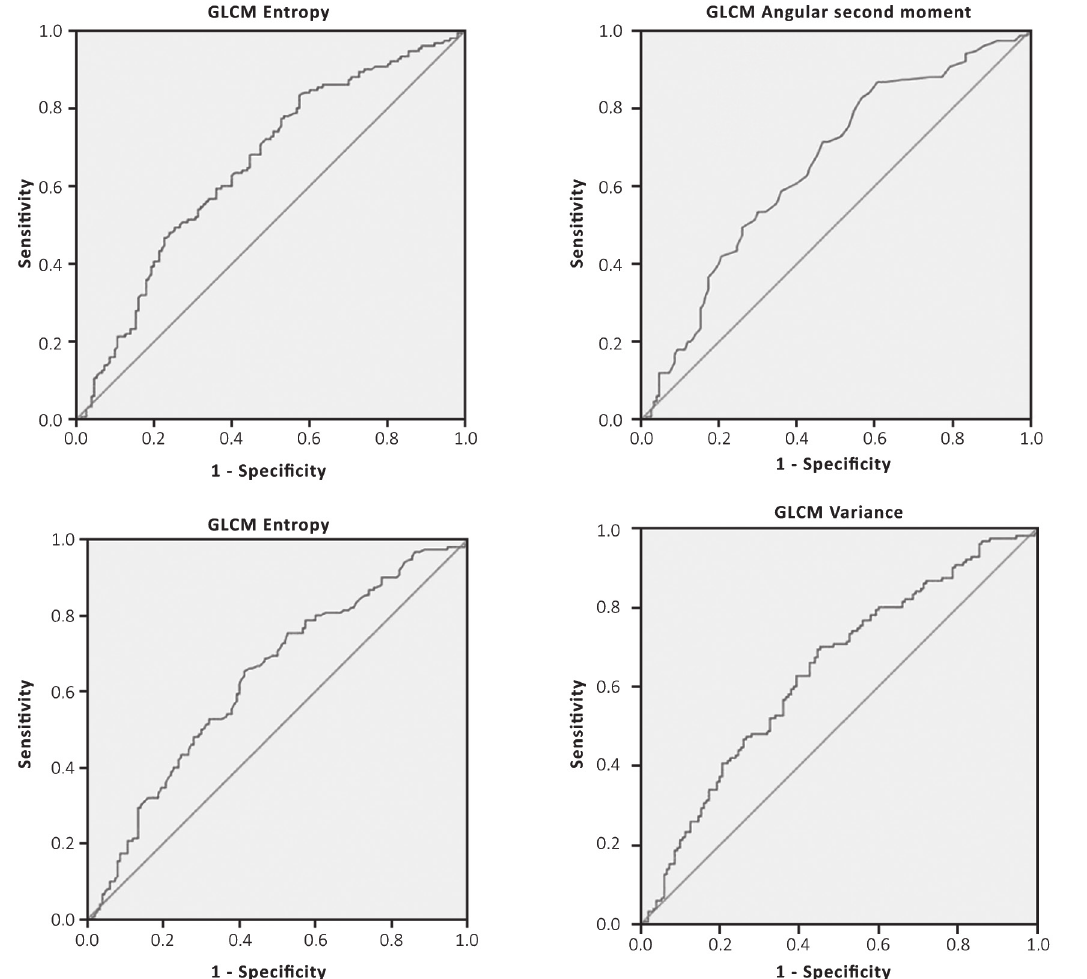
Figure 3 - Receiver operating characteristic (ROC) curves for GLCM